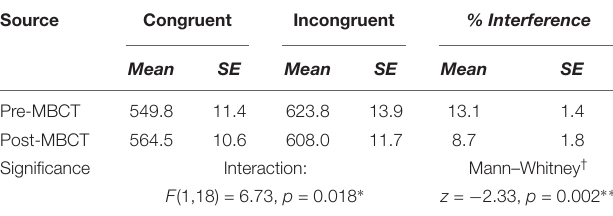
TABLE 2 | Comparison of reaction time and percentage interference between pre- and post-MBCT on grief